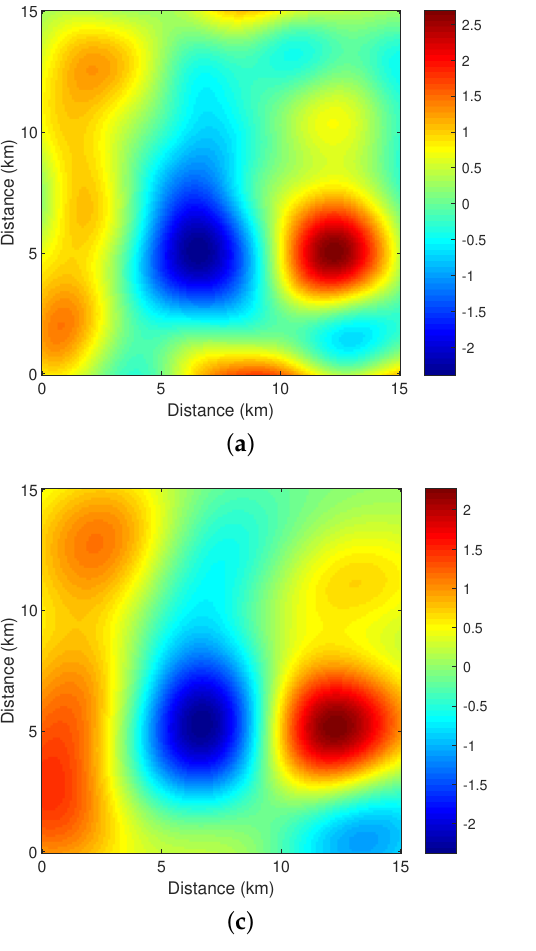
Figure 4. The true field and the estimated fields obtained by the three schemes. ( a ) True field; ( b ) Estimated field by Scheme 1; ( c ) Estimated field by Scheme 2; ( d ) Estimated field by Scheme